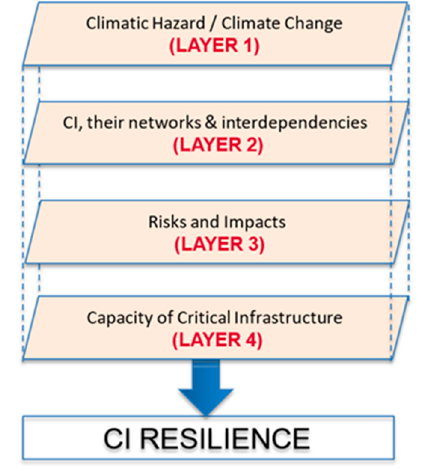
Figure 1. EU-CIRCLE resilience.